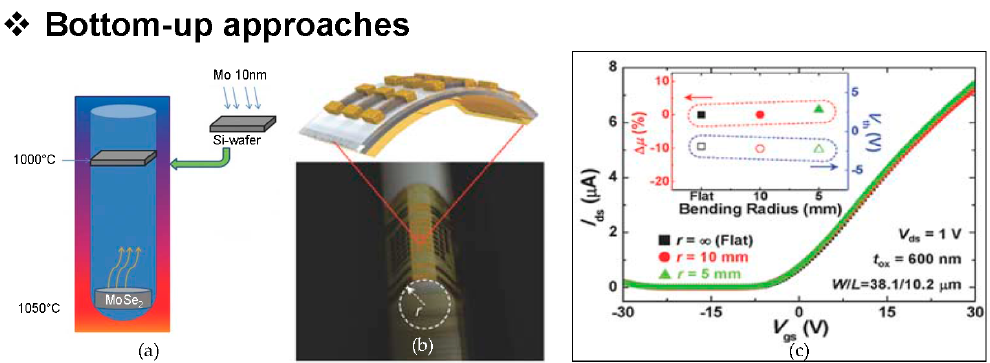
Figure 5. High-mobility transistors based on chemical vapor deposition (CVD)-grown MoSe 2 ; ( a ) schematic of synthesis of MoSe 2 film with modified CVD method; ( b ) optical image of bended MoSe 2 transistor; and ( c ) I–V characteristic of unbent and bent (up to 5 mm of radius) MoSe 2 transistor. Reproduced with permission from 2016 Advanced Materials [92].